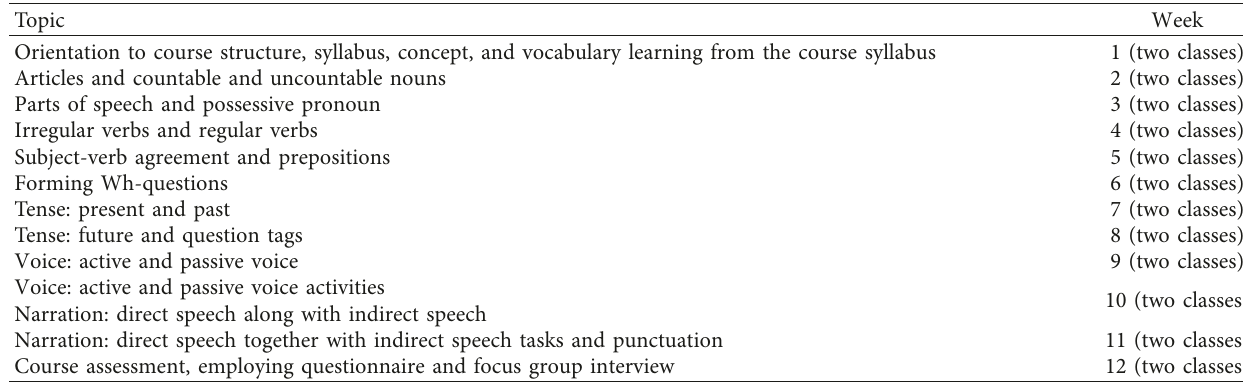
Table 3: Topics related to grammar for each class. Topic